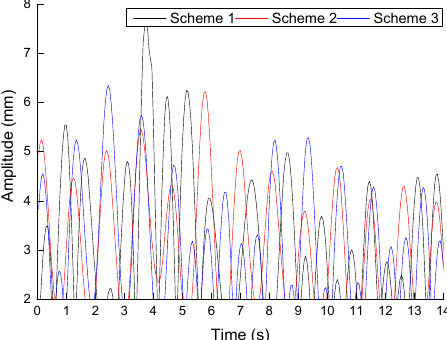
Figure 13. Amplitude change when h = 20 cm.